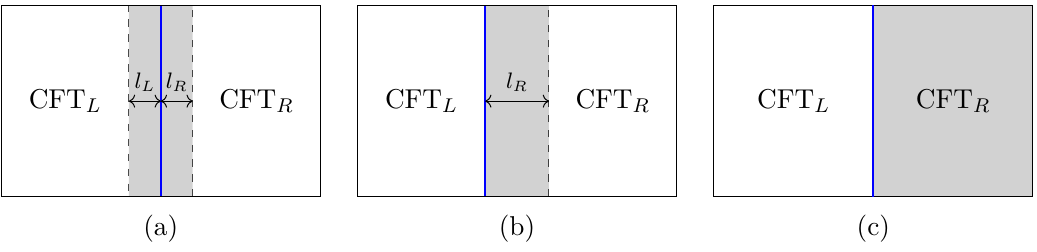
Figure 2 . For all three figures, the gray areas bounded by the dashed lines are subsystems A’s in the entanglement calculations. The blue lines are the interfaces. (a) A generic situation for case 1. The interface lives inside the spatial interval such that both l and l are nonzero. In this scenario, L R the interface is invisible to entanglement entropy at leading order in large l . The left and right boundaries of the interval both contribute c/ 6 to the prefactor of the leading term in entanglement entropy. (b) A special situation in case 1, where the interface coincides within left boundary of the interval such that l = l and l = 0 . The right boundary of the interval still contributes R L c/ 6 to the prefactor of the leading term in entanglement entropy, while the contribution from left boundary gains an additional factor that depends on the transmission coefficient of the interface, which holographically corresponds to e A ∗ . (c) Case 2. When the subsystem A extends to infinity on the right, the only contribution to the leading entanglement entropy comes from the left boundary of subsystem